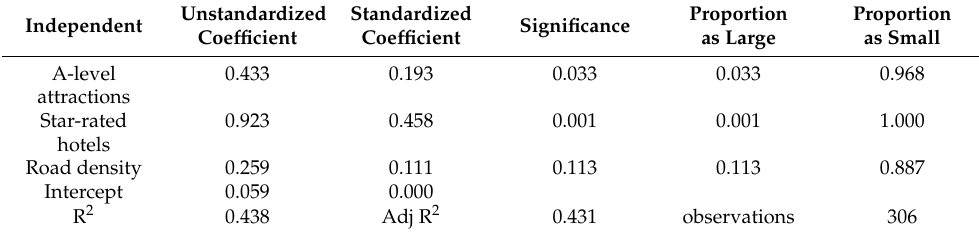
Table 6. QAP regression